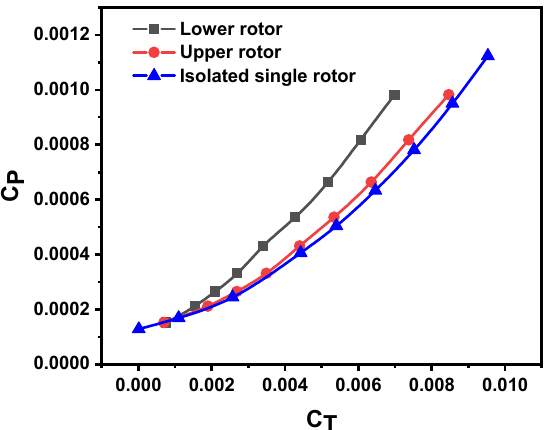
Figure 6. Relationships between power coefficient (C P ) and thrust coefficient (C T ) of upper, lower, and isolated single rotors.